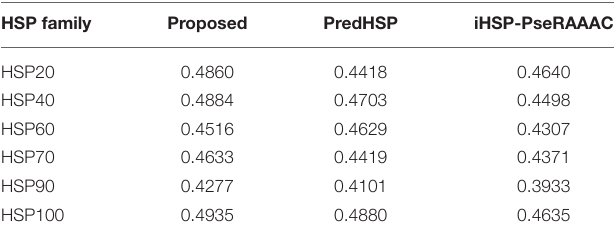
TABLE 5 | Values of AUC-PR for classification of different families of HSP, by the proposed approach and two other existing approaches.